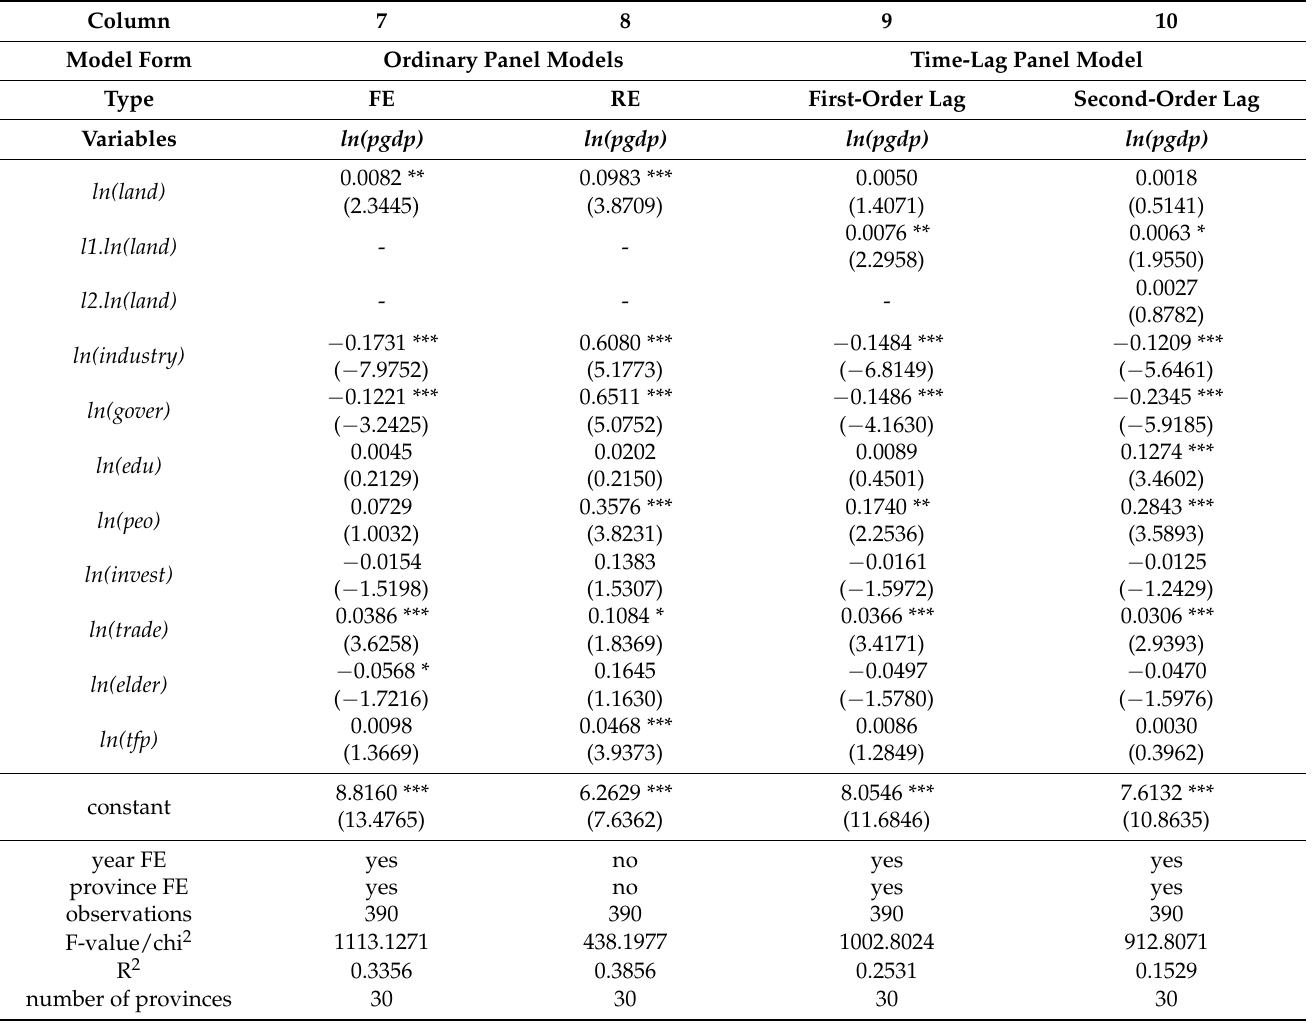
Table 3. Time-lag effect of TLT on economic